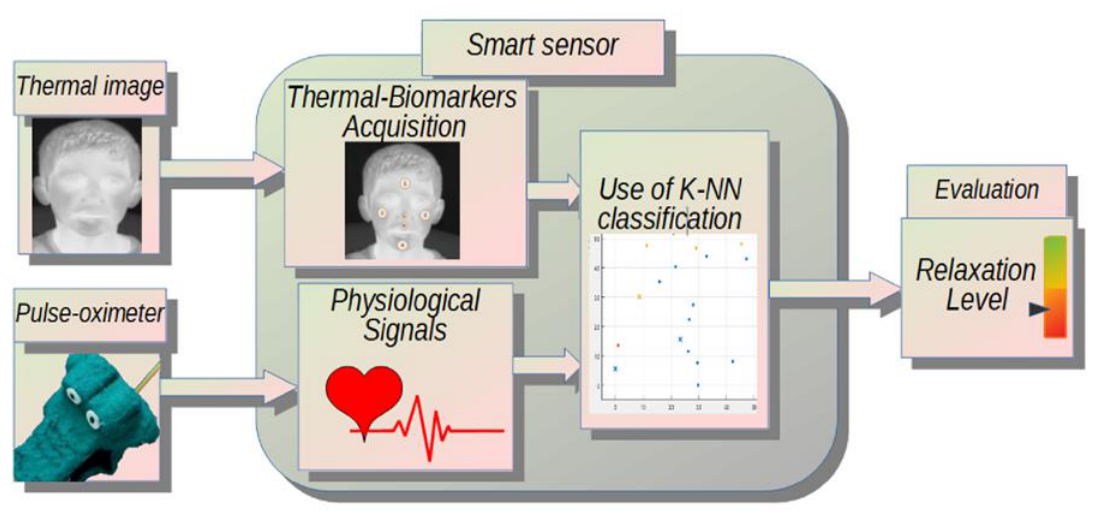
Figure 5. Smart sensor diagram.